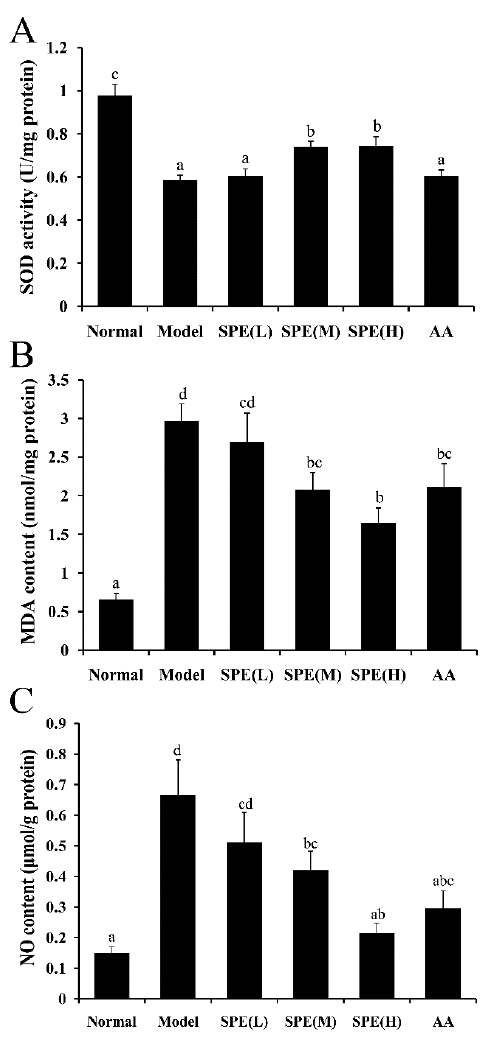
Figure 4. The effects of sheep placental extract (SPE) on the superoxide dismutase (SOD) activity, the malondialdehyde (MDA) content and nitric oxide (NO) content after 8 h of administration of Con A. The activity of SOD, the content of MDA and the content of NO in the liver tissues of Con A-induced mice are shown in ( A – C ), respectively. Values are represented as means ± SE ( n = 11). a, b, c, d, ab, bc, cd and abc in the figures indicate statistically significant differences ( p < 0.05) among groups. The experimental groups pretreated with low dose SPE (5 mg/kg), medium dose SPE (10 mg/kg), high dose SPE (50 mg/kg) or the mixture of 18 amino acids equal to the 50 mg/kg SPE group are labelled as SPE (L), SPE (M), SPE (H) and AA,